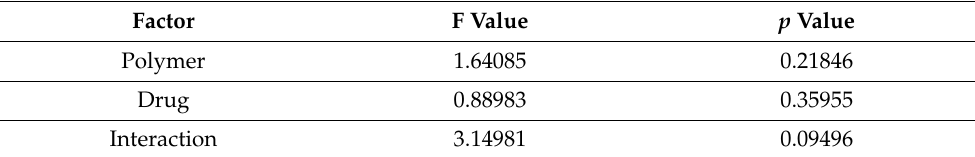
Table 6. Analysis of W adh